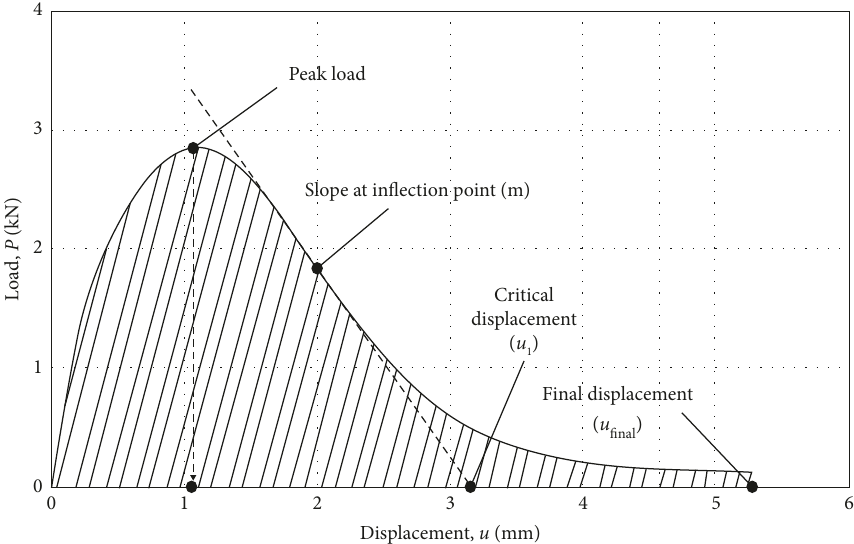
Figure 7: Calculation of the fracture work region. Table 8: Parameters of the semicircular splitting tests.